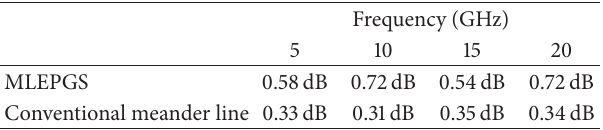
Table 1: Insertion losses of the MLEPGS and conventional meander line with a length of 𝜆 /8.